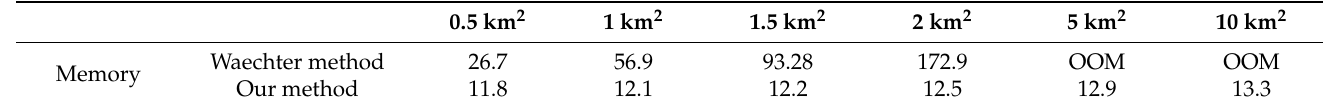
Table 2. Comparison of the memory consumed using the two methods for texture reconstruction in different experimental areas.